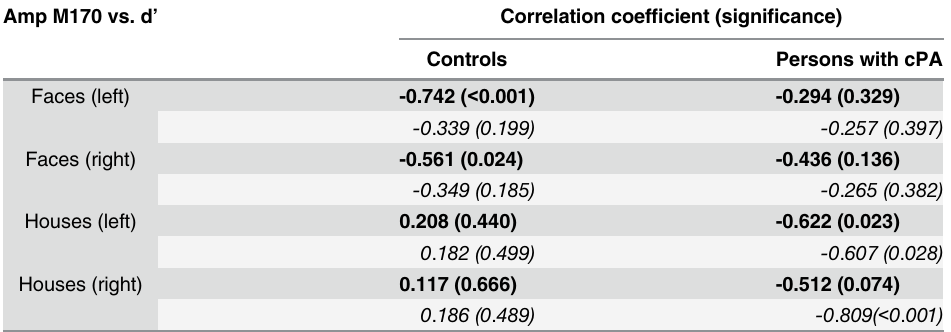
Table 4. Brain-behaviour correlations. Bold numbers denote correlation coefficients and level of signifi- cance (numbers in brackets) for M170 amplitude vs. d ’ (the z-transform of hits corrected by false alarms). The corresponding analysis with percent correct is presented by italicized numbers.